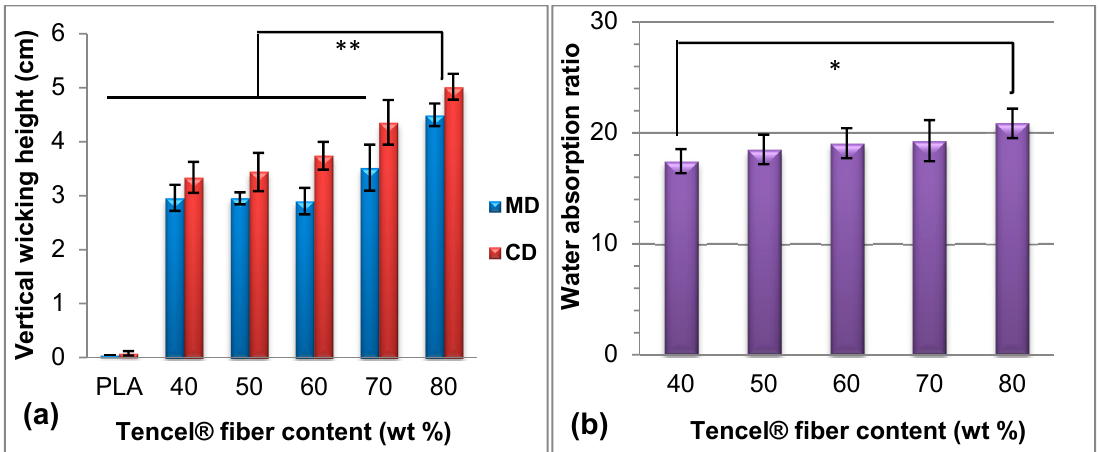
Figure 2. ( a ) Vertical wicking height and ( b ) water absorption of Tencel ® /Absorbent-Cotton/PLA (TCP) nonwovens with various fiber blendings. ** p < 0.01; * p < 0.05.